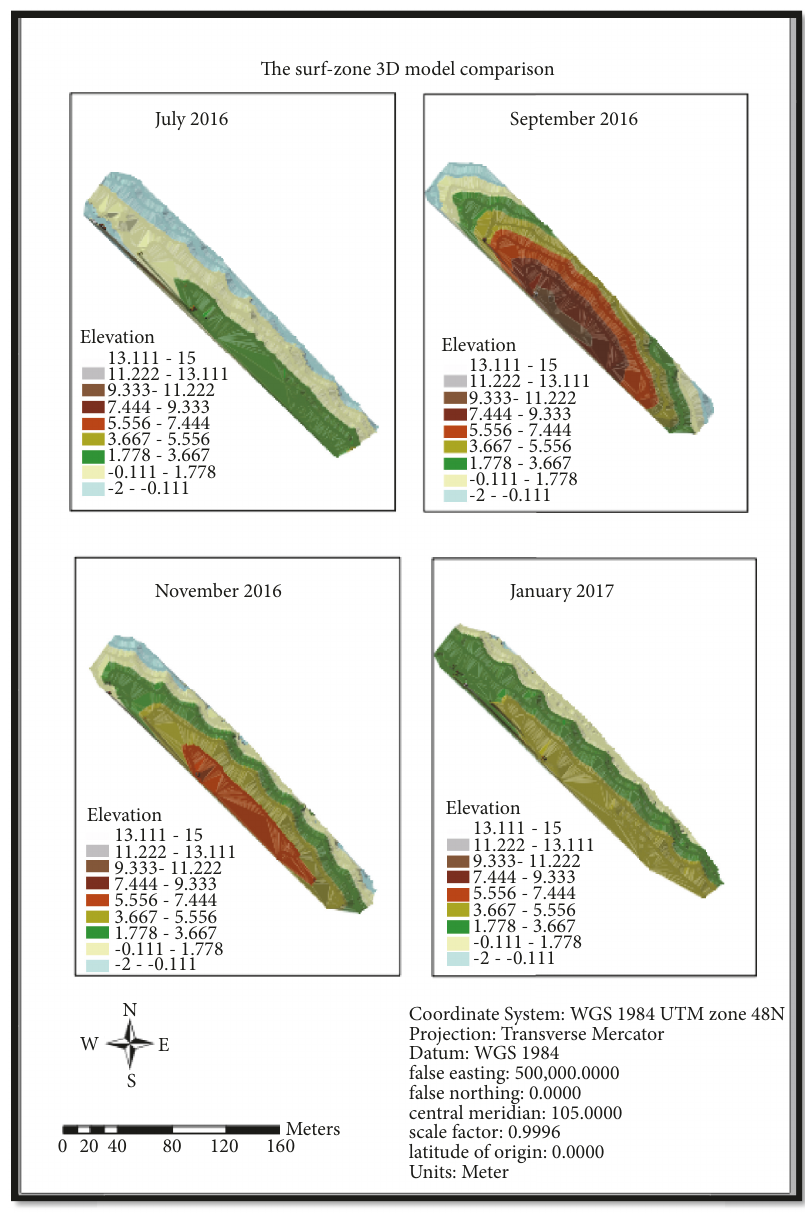
Figure 13: Triangulated irregular network for surf mapping